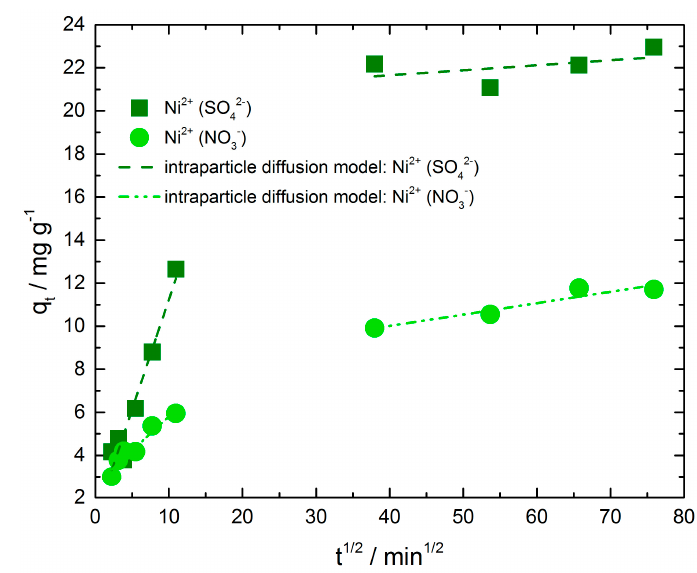
Figure 5. Intra-particle diffusion kinetic plot for nickel adsorption from nickel sulfate and nickel nitrate solution. Table 3. Kinetic parameters from intra-particle diffusion model for the adsorption of nickel from nickel sulfate and nickel nitrate